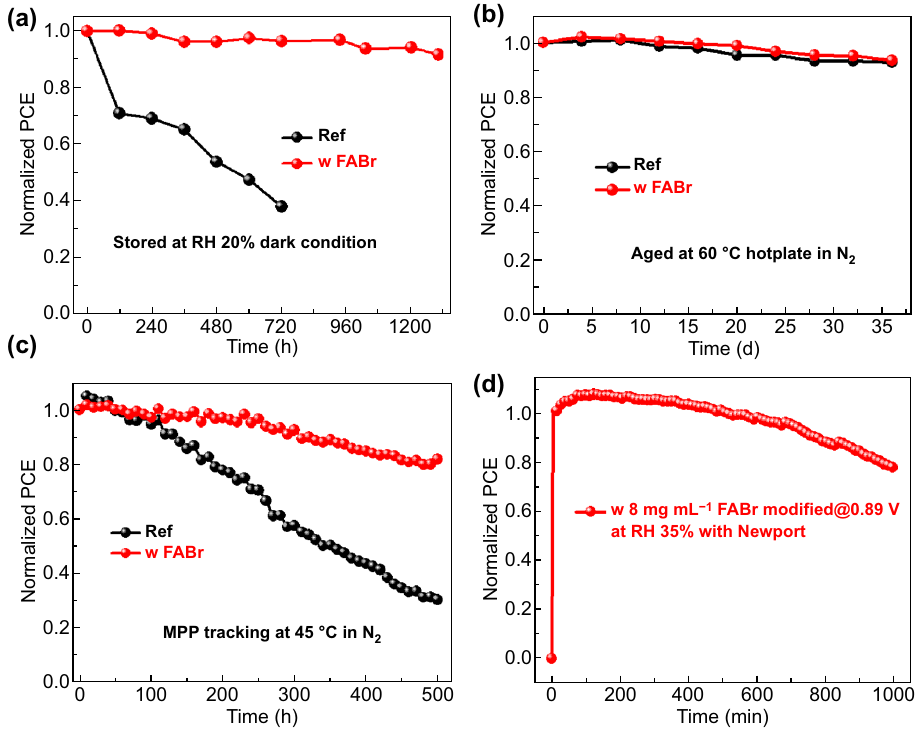
Fig. 5 a Moisture stability of the related devices measured under controlled RH 20% ambient condition. b Thermal stability of the correspond- ing devices aged at 60 °C hotplate. c MPP tracking of various devices at 100 mW cm −2 illuminated at 45 °C. d MPP measurement with Newport under controlled RH 35% ambient